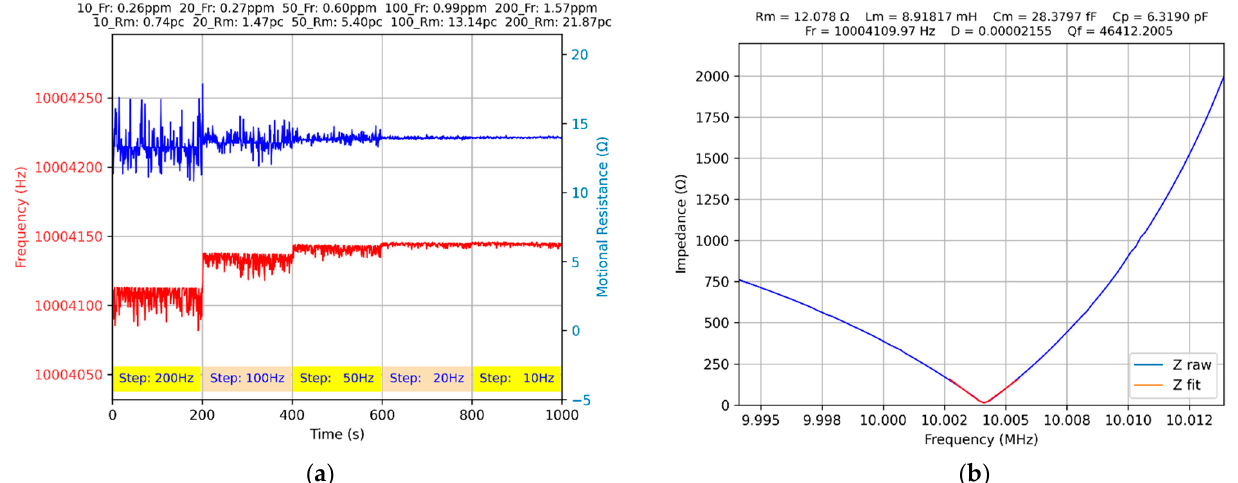
Figure 6. The QCM sensor measured in air: ( a ) accuracy of series resonant frequency (ppm) and motional resistance (%), ( b ) series resonant frequency tracking with constant step equal to 200 Hz.